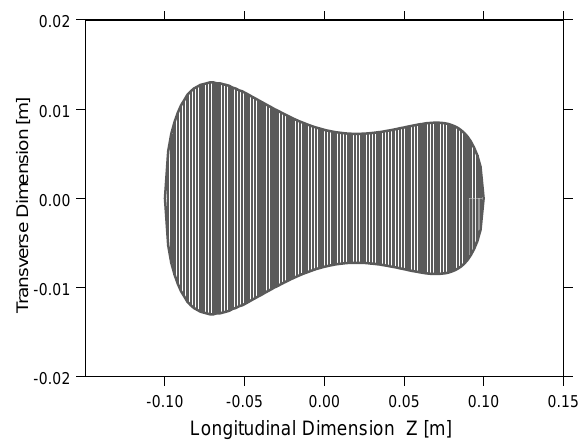
FIG. 1. Beam bunch with total charge of 10 2 11 C and a longi- tudinally asymmetric charge density inside a round metal pipe 4 cm in